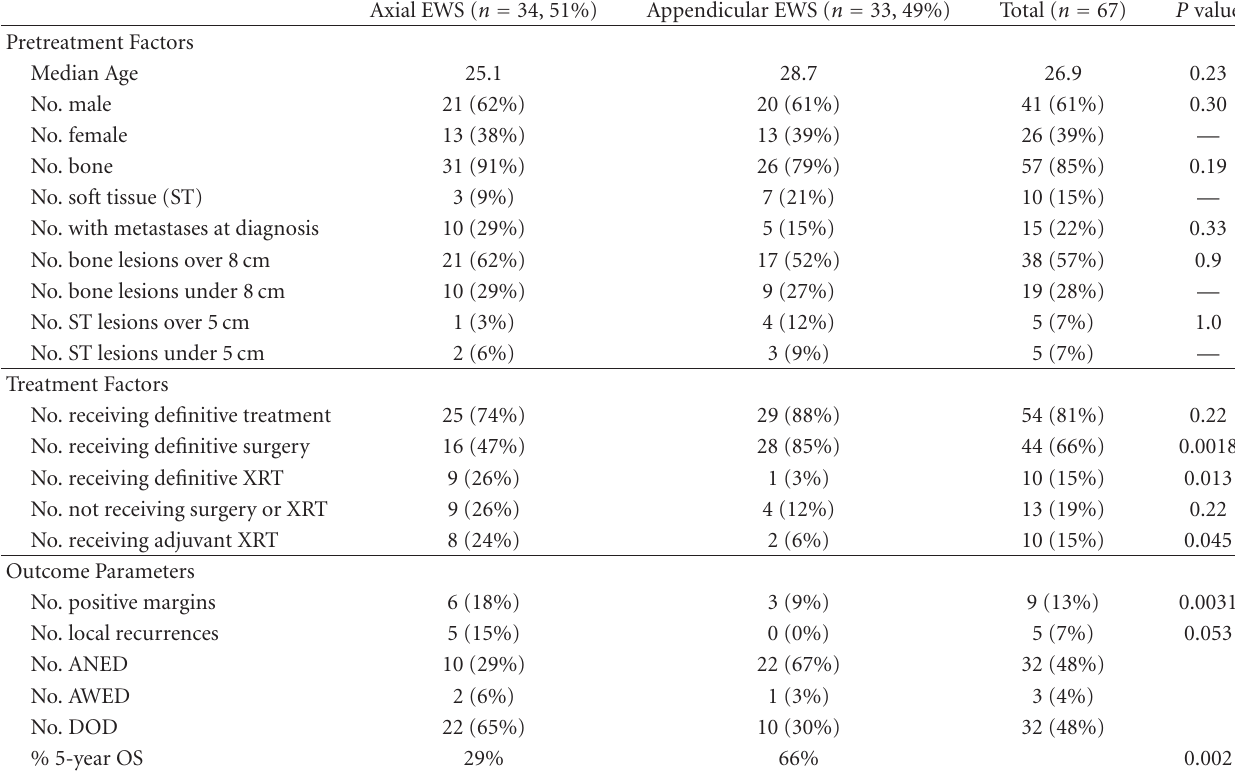
Table 1: Patient Information. Table 1 depicts demographic data, pretreatment characteristics, and treatment characteristics for the axial EWS and appendicular EWS groups.